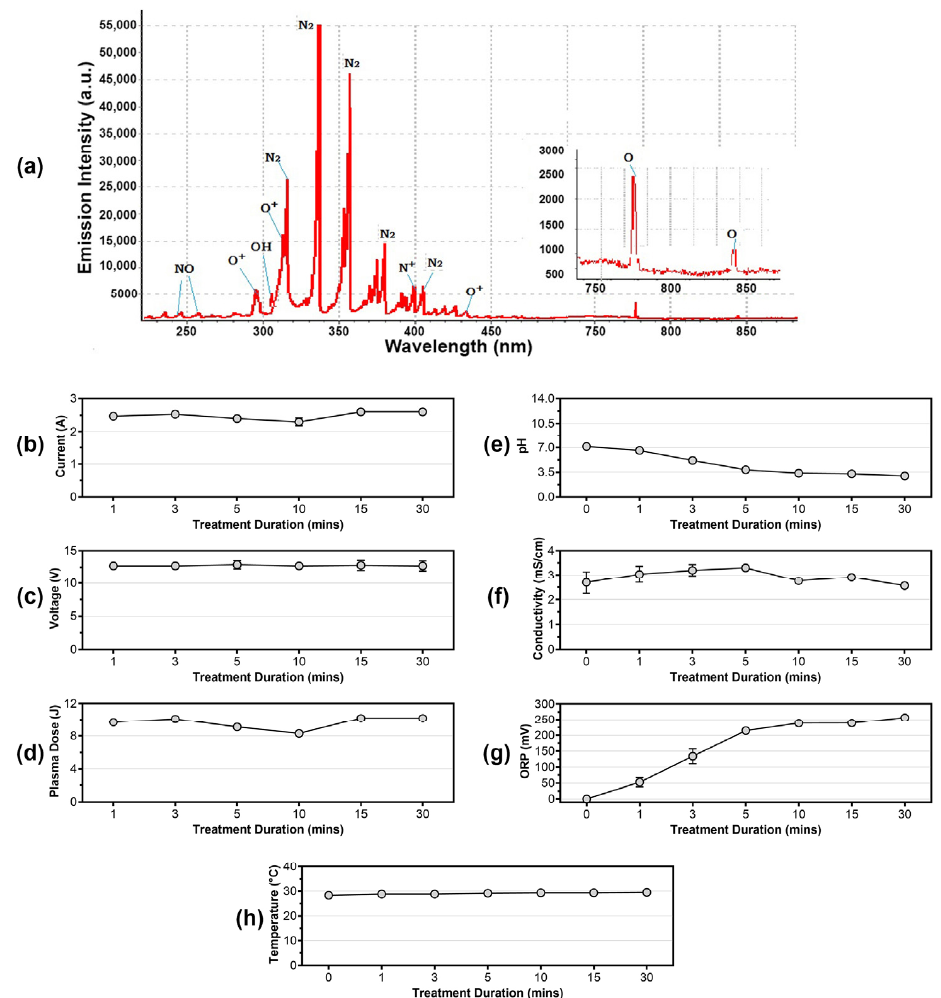
Figure 2. ( a ) Optical emission spectrum (OES) of cold plasma. Measurement of ( b ) current, ( c ) voltage, and ( d ) plasma dose of the in-house built cold plasma device at different treatment durations. Detection of ( e ) pH changes, ( f ) electrical conduction, and ( g ) oxidation-reduction potential (ORP) of the cold plasma-treated solution. Measurement of ( h ) cold plasma temperature from 0 min to 30